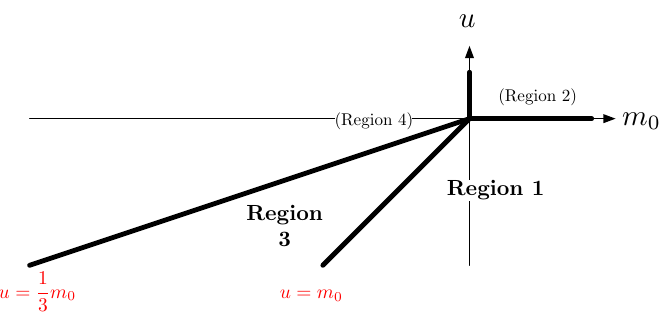
E 1 theory. The line between Region 1 and Region 3 is e